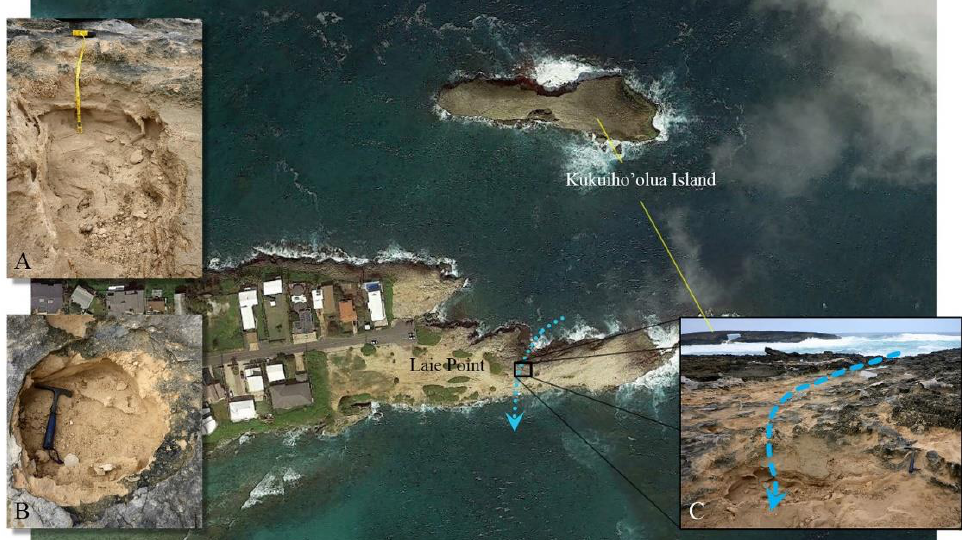
Figure 5. Evidence for waves over-topping the peninsula at Laie Point, Oahu. Examples include oxidized surface removal ( C ) and erosion pits ( A and B ). View in C is looking north. Arrow indicates likely flow path of seawater. Base map from Google Earth.